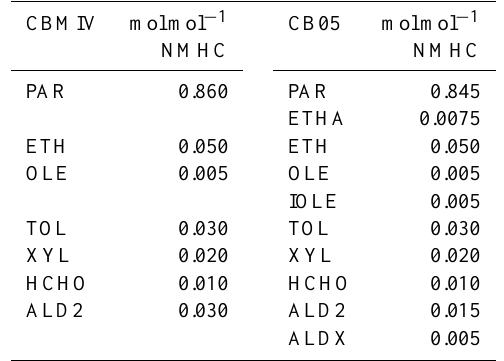
Table 3. Nonmethane Hydrocarbon (NMHC) species apportion-